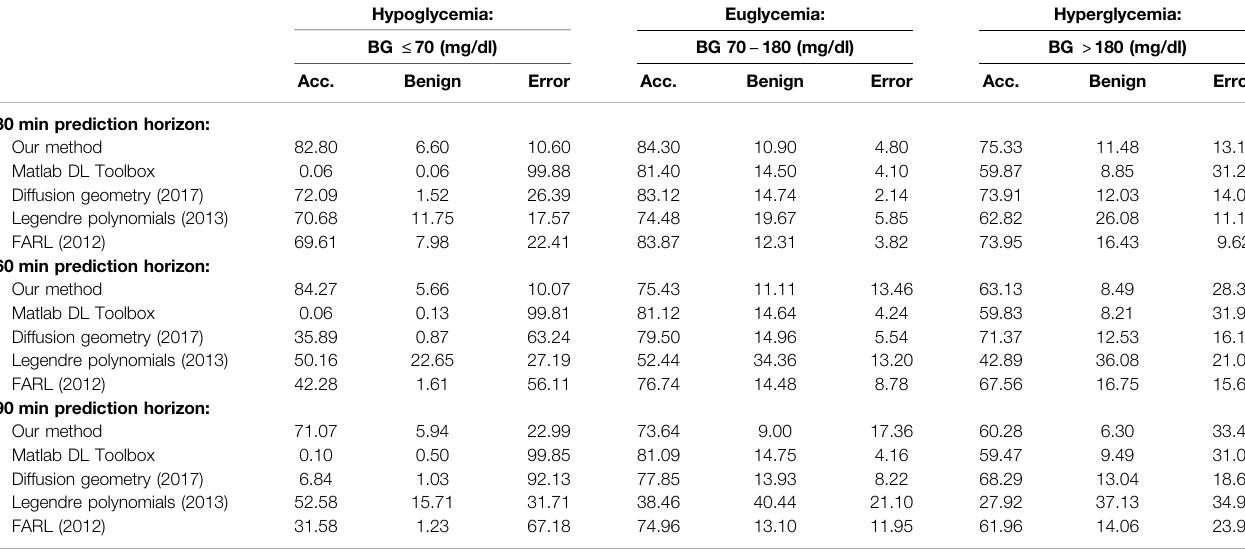
TABLE 4 | Average PRED-EGA scores (in percent) for different prediction horizons on dataset J . Hypoglycemia: Euglycemia: